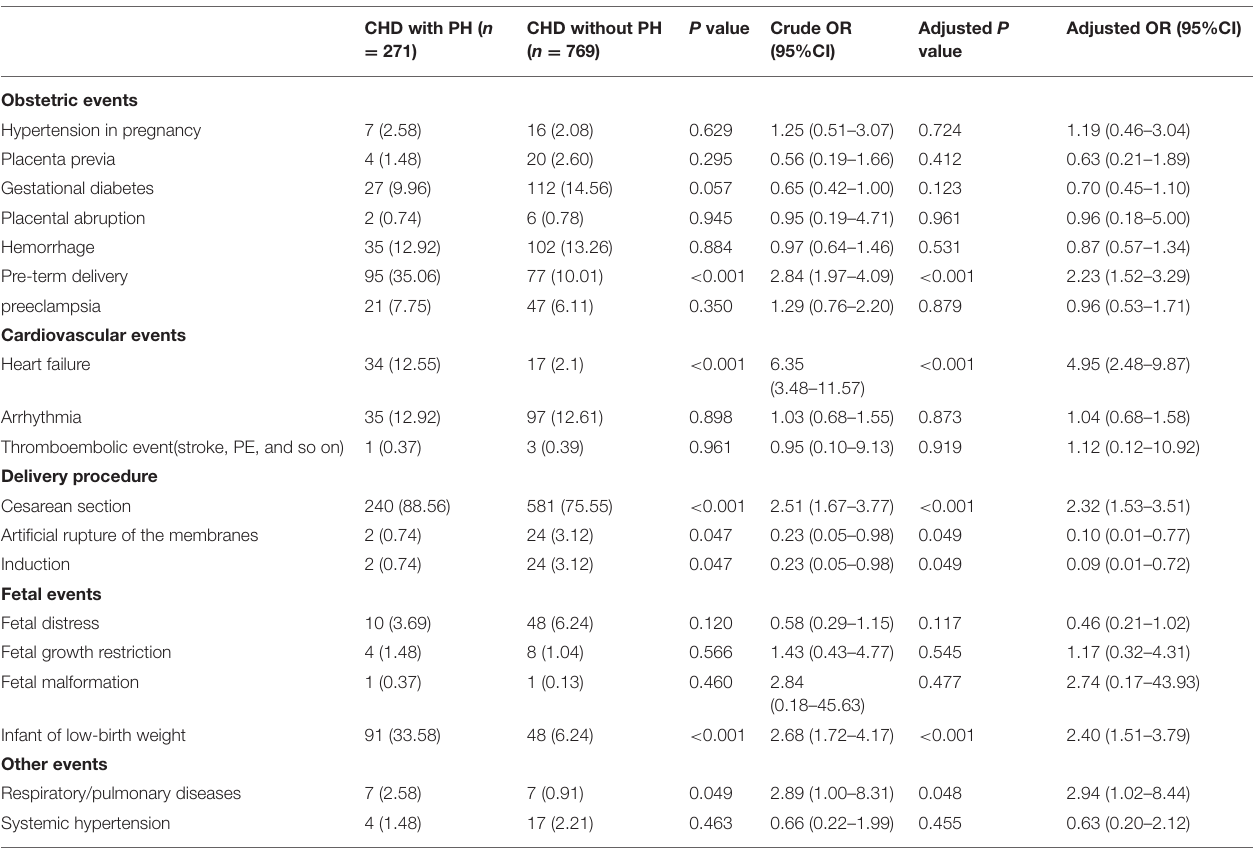
TABLE 3 | Adverse cardiovascular, obstetric, and fetal events experienced by women with CHD admitted for delivery by presence of PH.